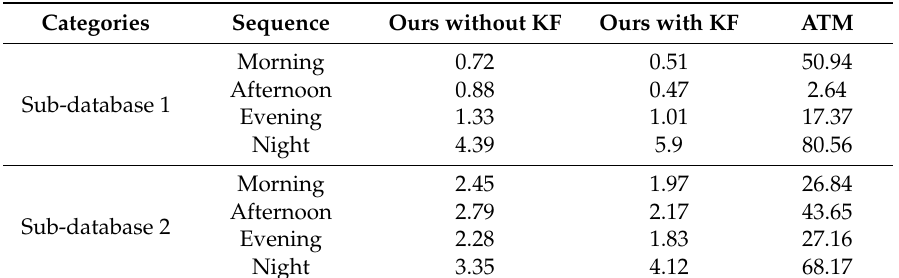
Table 4. Comparisons of average PDE obtained by our method with those obtained by other methods